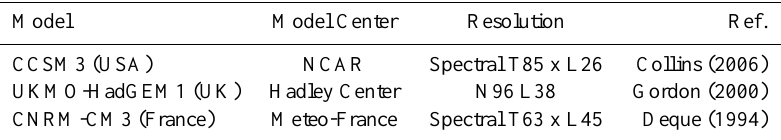
Table 1. AMIP II models used in this